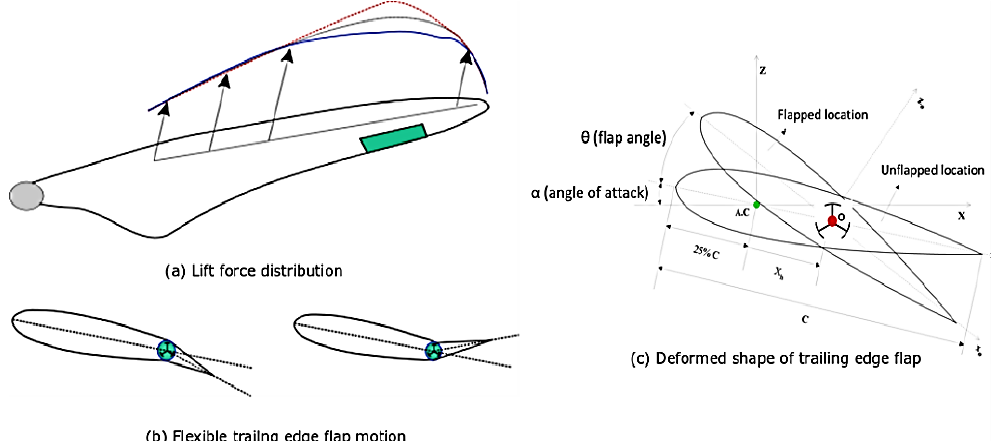
Figure 6. (a) Aerodynamic force distribution; (a) and (b) deformed cross-sectional shape of flexible trailing edge flap